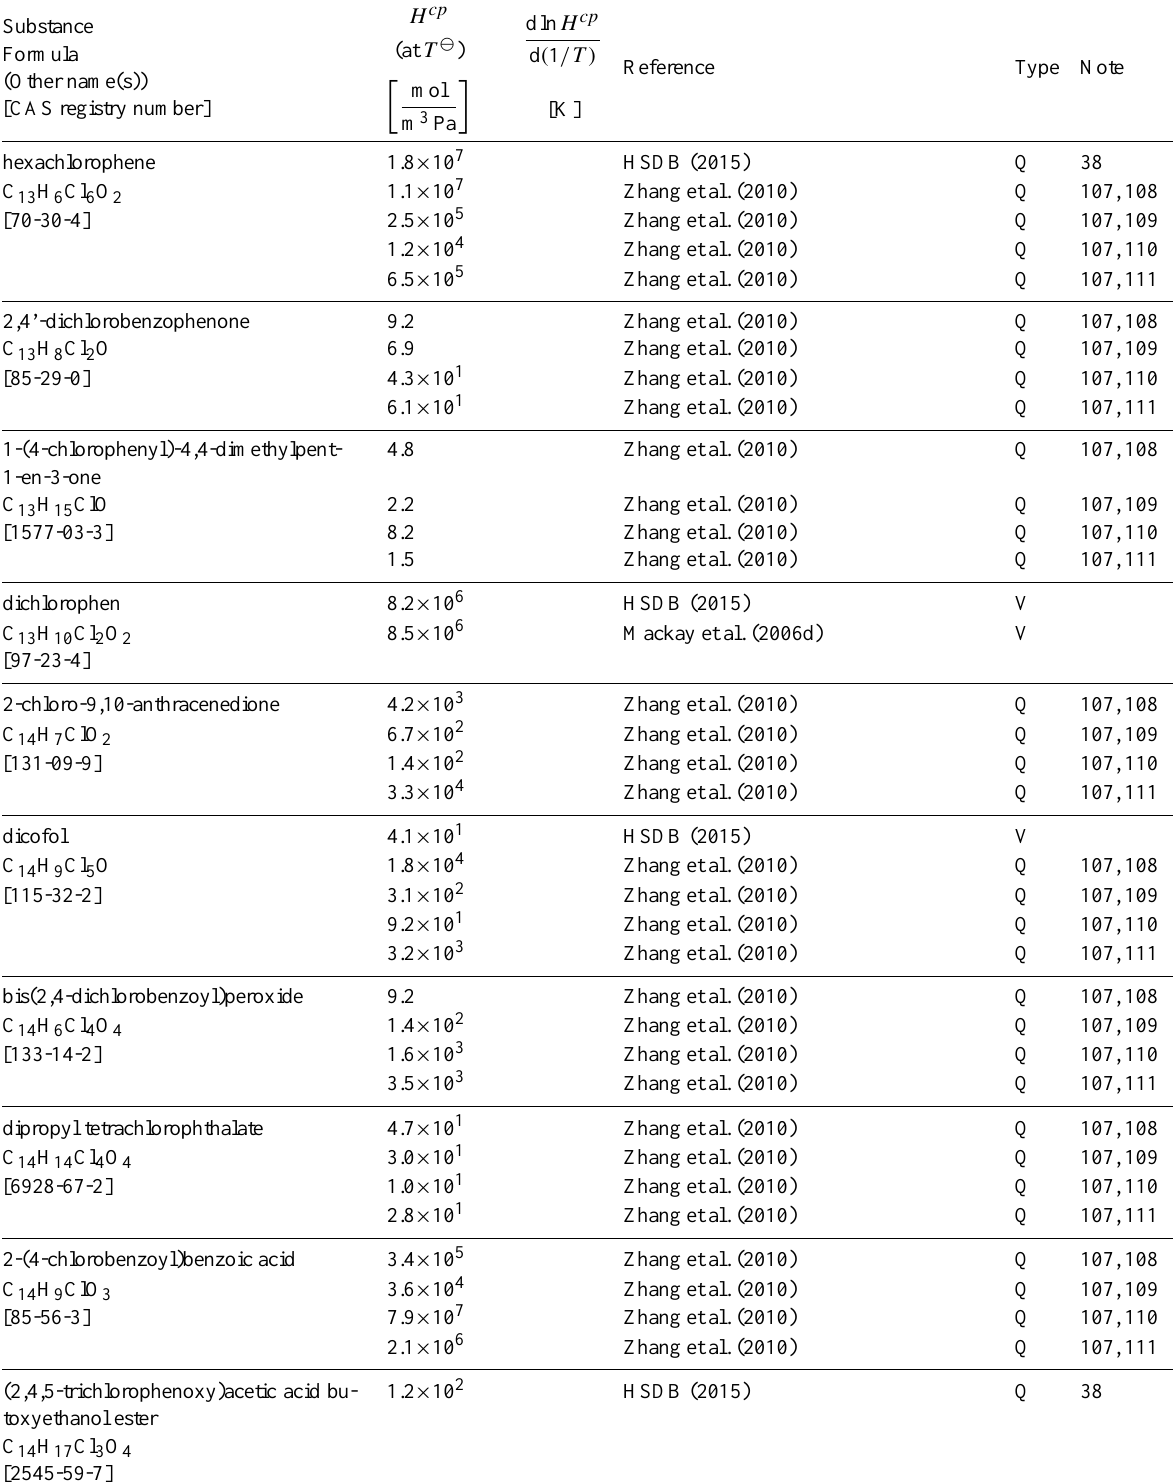
Table 6: Henry’s law constants for water as solvent